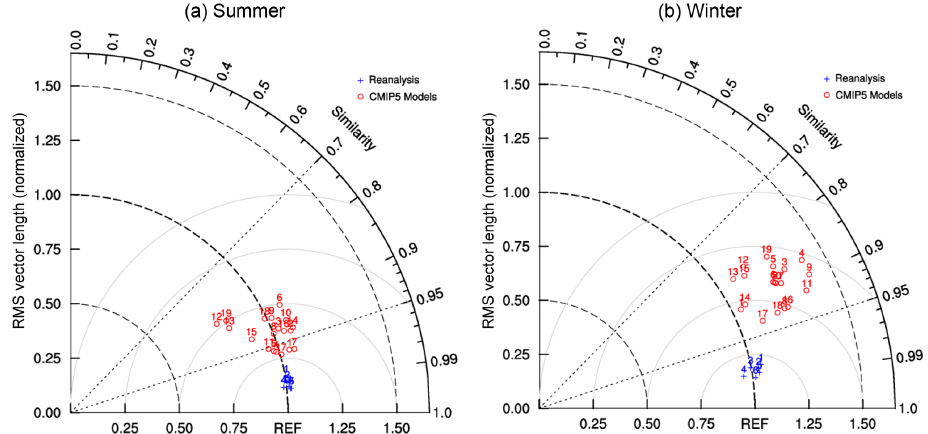
Figure 10. Normalized pattern statistics of climatological mean 850hPa vector winds in the Asian–Australian monsoon region (10 ◦ S–40 ◦ N, 40–140 ◦ E) derived from the historical simulations of 19 CMIP5 models (red circles) and 6 reanalysis datasets (blue crosses) compared with the multi-reanalysis mean during the period from 1979 to 2005. The RMSL and the RMSVD have been normalized by the RMSL derived from multi-reanalysis mean data. The data were excluded from the statistics in areas with topography higher than 1500m. Six reanalysis datasets (NNRP, NCEP2, ERA-40, ERA-Interim, JRA25, and JRA55) were included in the